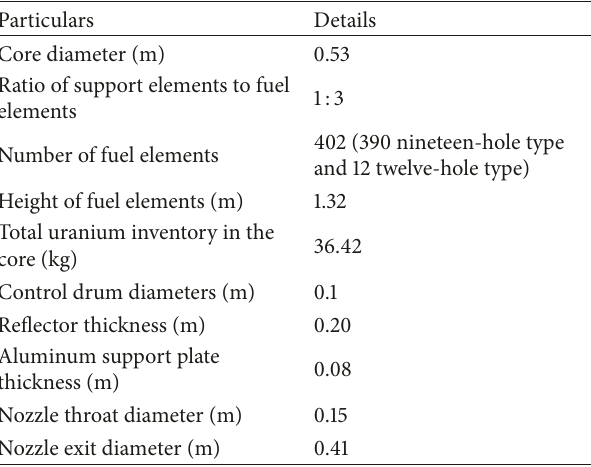
Table 1: Specifications of the Pewee I